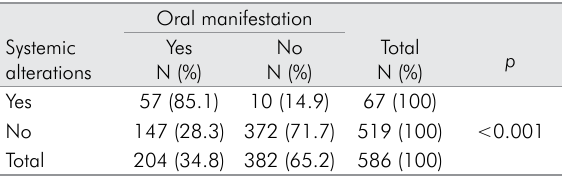
Table 3. Distribution of oral manifestations according to cases of systemic